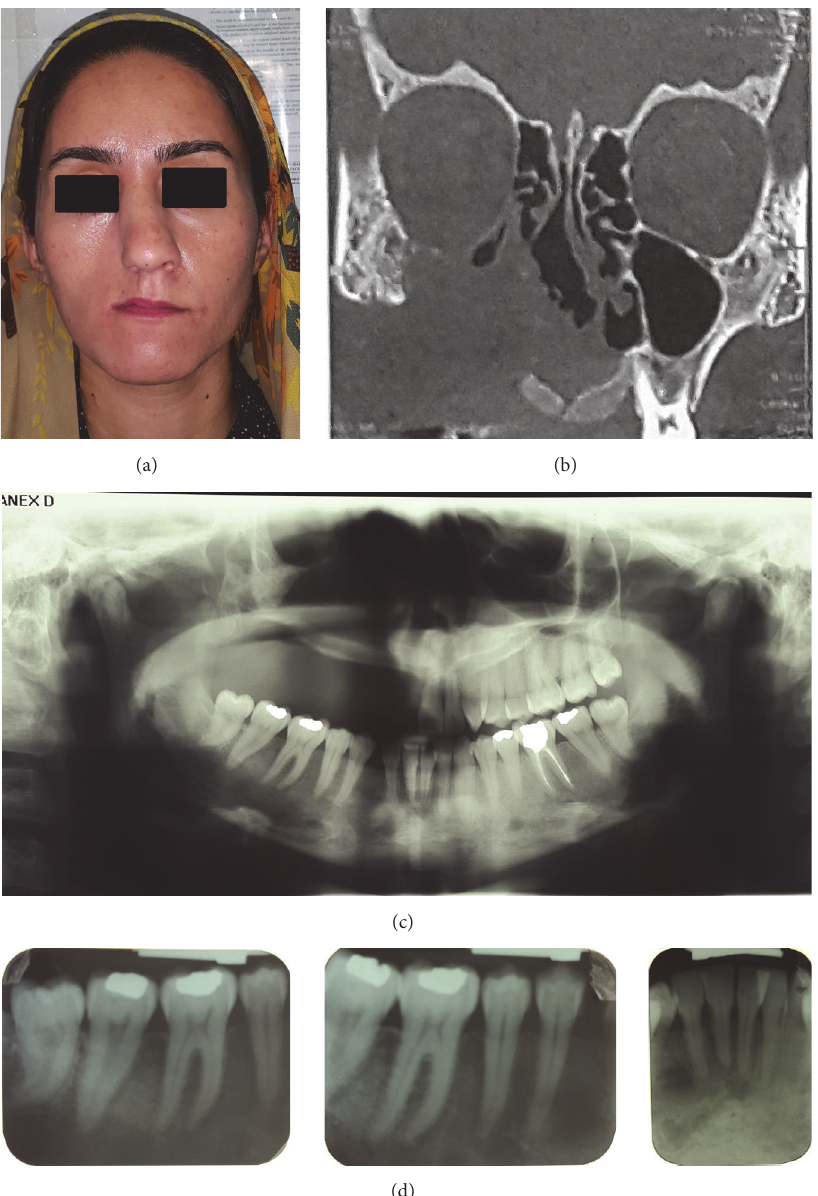
Figure 6: Postoperative course (18 months after surgery). (a) Extraoral frontal photography. (b) CT scan coronal axis. (c) Panoramic view. (d) Periapical